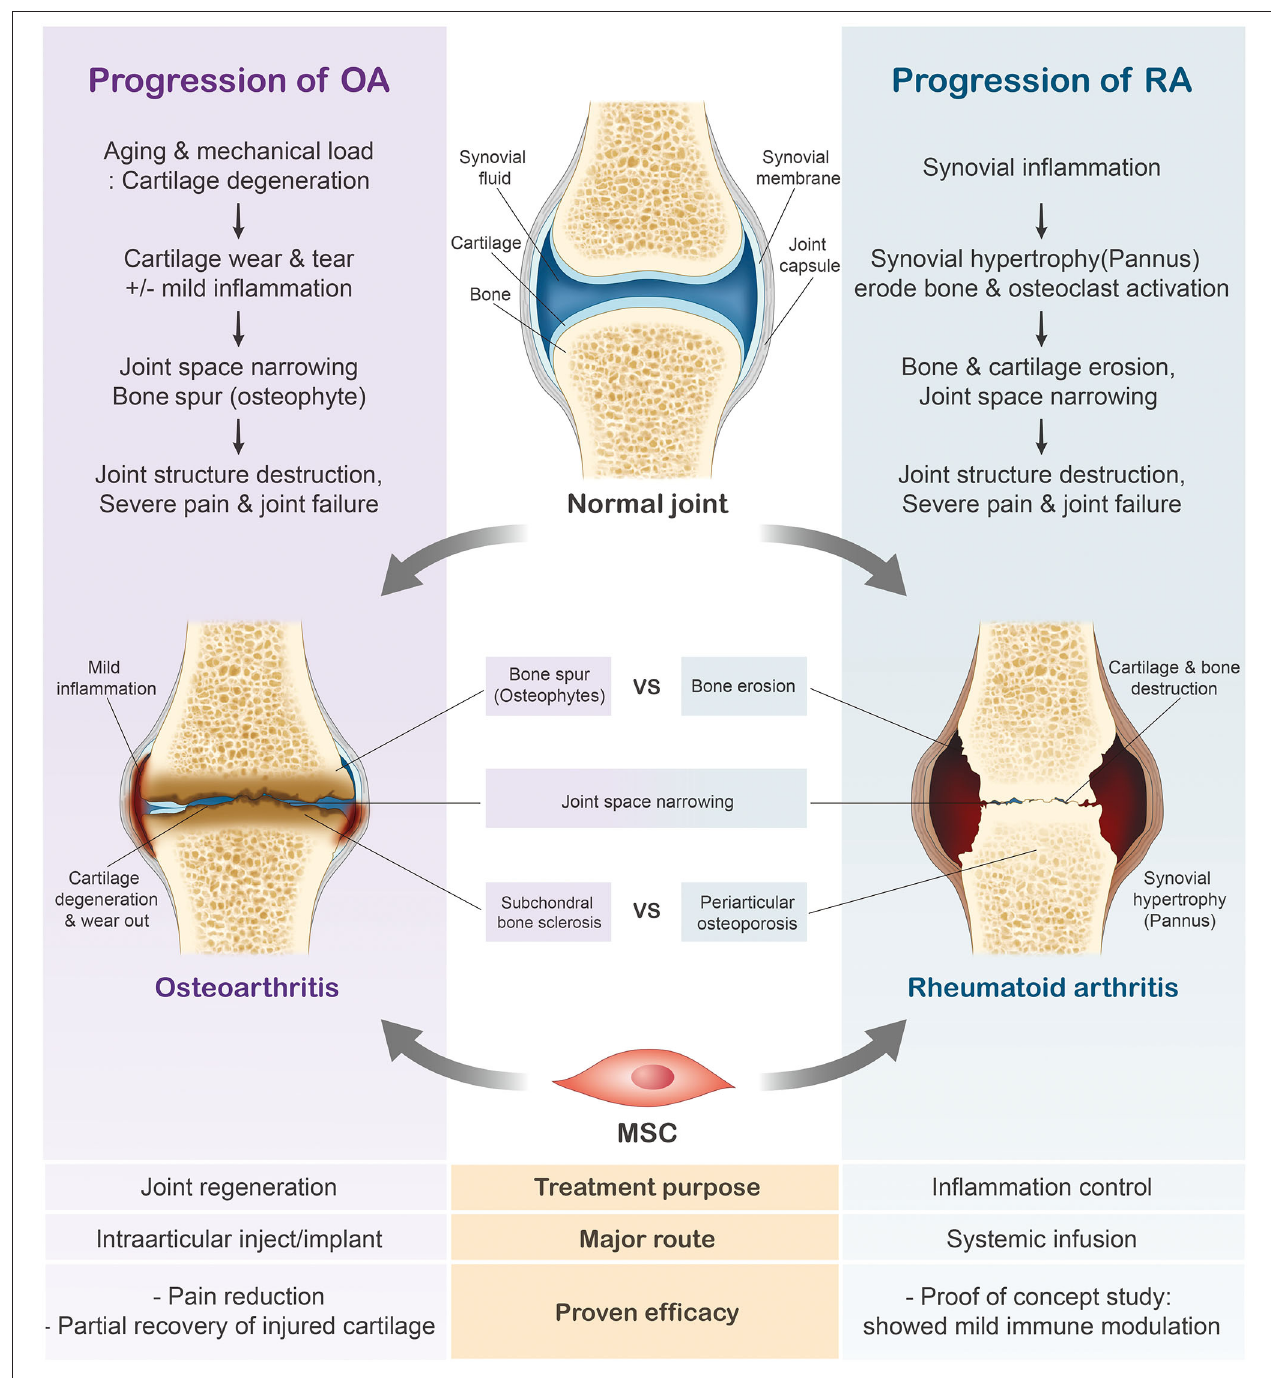
FIGURE 2 | Progression of rheumatoid arthritis (RA) and osteoarthritis (OA). In contrast to the healthy joint, the osteoarthritic joint has thinned cartilage and the bone ends rub together. Joints diagnosed with RA have swollen, inflamed synovial membranes and undergo bone erosion. The cartilage erosion seen in the later stages of arthritis ultimately leads to the loss of